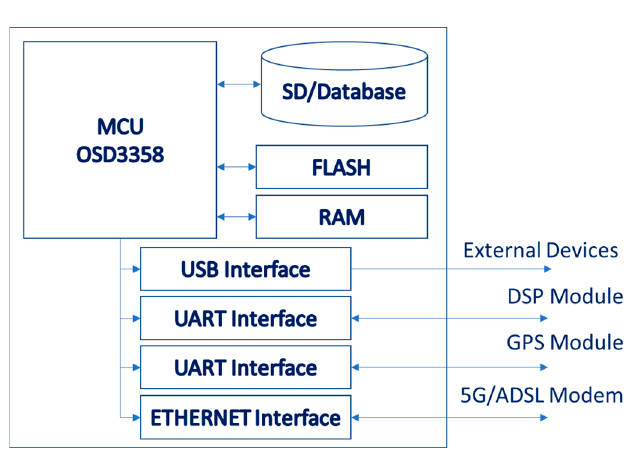
Figure 5. High-level architecture of the edge processing module.